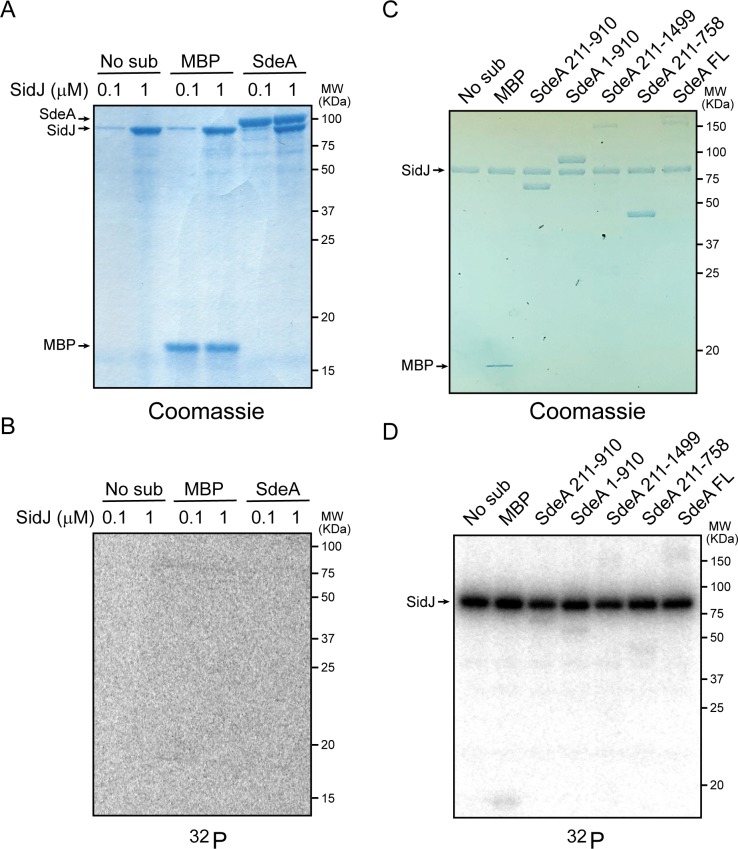
SidJ lacks canonical kinase activity but exhibits auto-AMPylation activity.(A) Two concentrations of SidJ (0.1 μM and 1 μM) were incubated with CaM, MgCl2 and [γ-32P]ATP without substrate, with MBP, and with SdeA 1–910 for 30 min at 37°C. Proteins were separated by 12% SDS-PAGE and visualized with Coomassie stain. (B) Autoradiogram of the gel shown in panel (A). Exposure time: 2 hr. (C) SidJ was incubated with CaM, MgCl2 and [α-32P]ATP without substrate, with MBP, and with the indicated recombinant SdeA truncations. Proteins were separated by 8% SDS-PAGE and visualized with Coomassie stain. (D) Autoradiogram of the gel shown in panel (C). Exposure time: 1 hr. The bands corresponding to SidJ showed strong radiographic signals, indicating auto-AMPylation of SidJ.